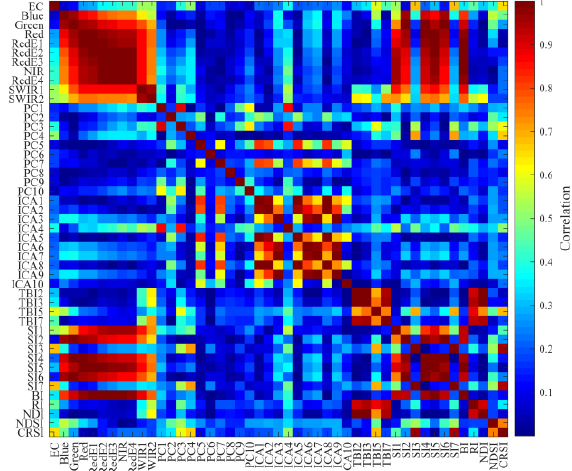
Figure 4. Correlation matrixes document the correlation between electrical conductivity and multi-spectral features, and the correlation between